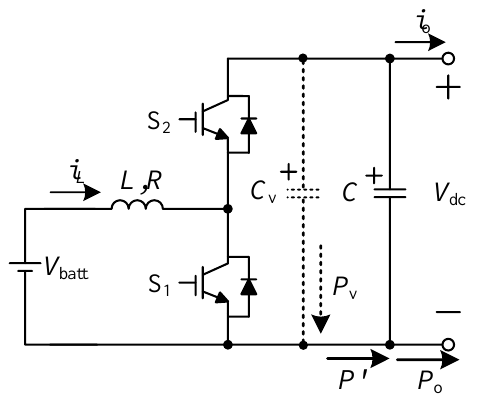
Figure 2. The battery bidirectional DC/DC converter model and the power relationship on the capacitor side.